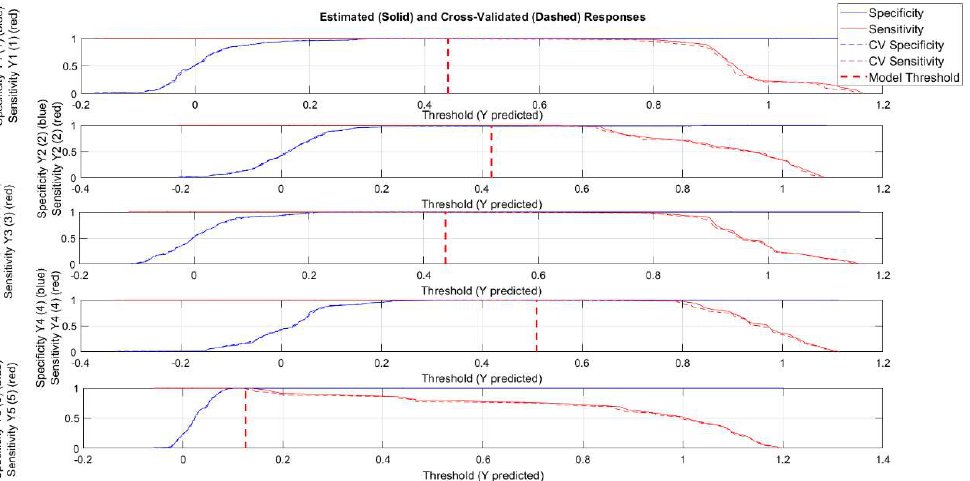
Figure 8. Threshold plots for PLS-DA model. The vertical dashed red line indicates the threshold selected by the PLS-DA